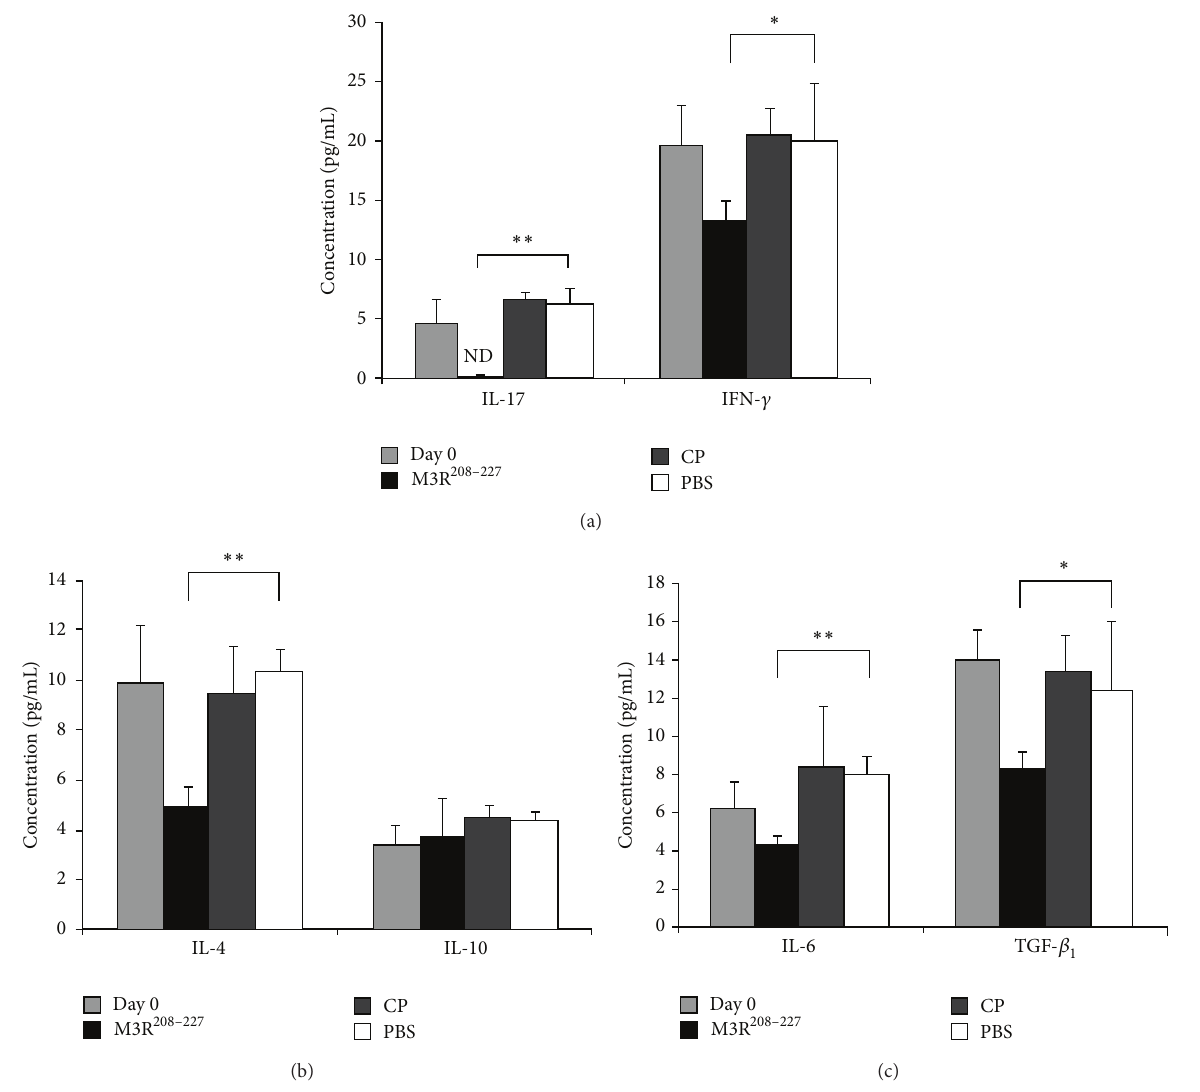
Figure 2: Downregulated expression of IFN- 𝛾 , IL-4, IL-17, IL-6, and TGF- 𝛽 1 in the serum following immunization with the M3R 208−227